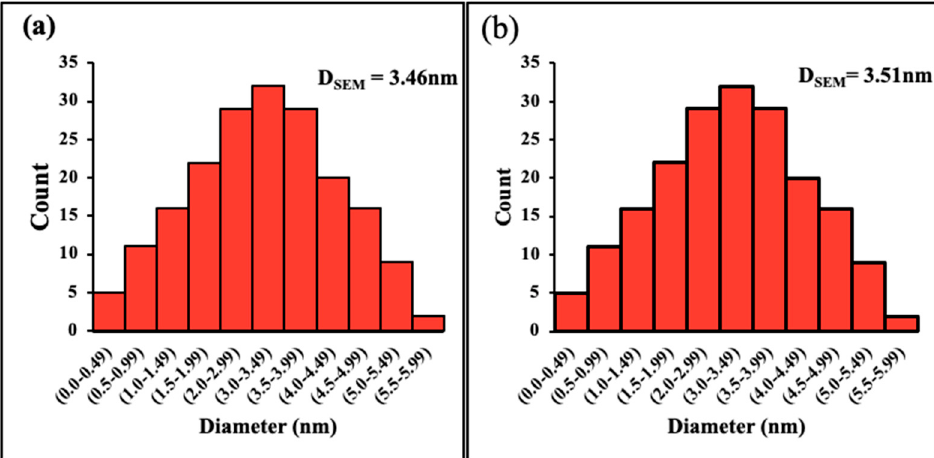
Figure 3. Particle size distribution of ZnO in 5 wt.% ZnO-chitosan ( a ) and 10 wt.% ZnO-chitosan ( b ) nanocomposites.